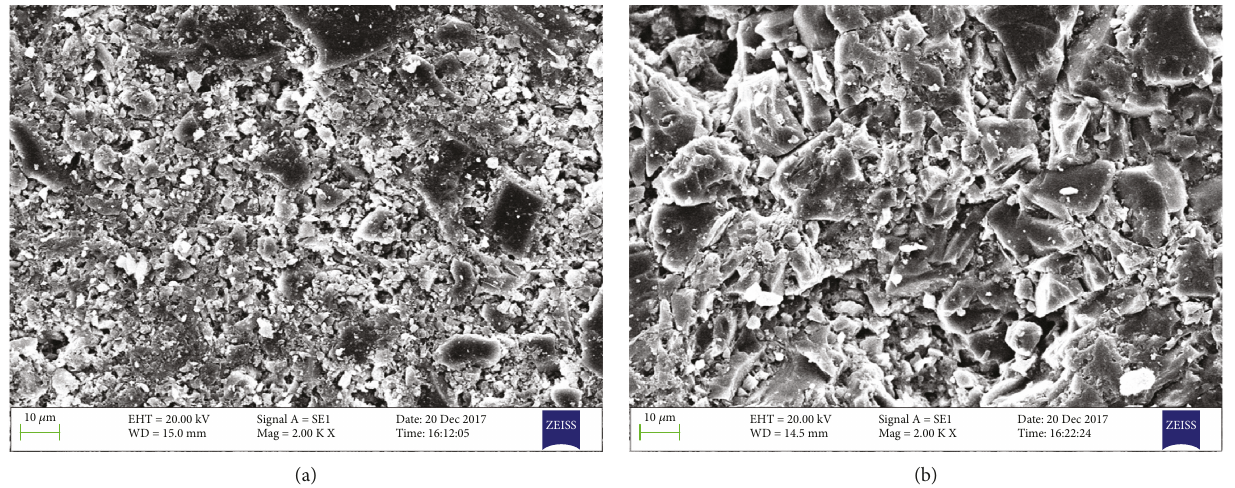
Figure 10: SEM images of these two man-made siltstones. (a) Fine siltstone. (b) Coarse siltstone.